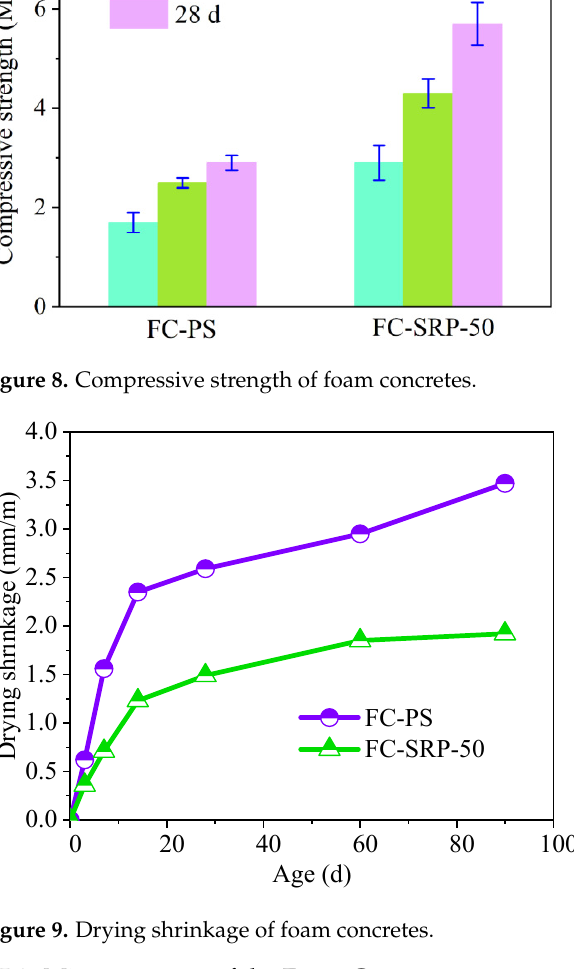
Figure 9. Drying shrinkage of foam concretes.